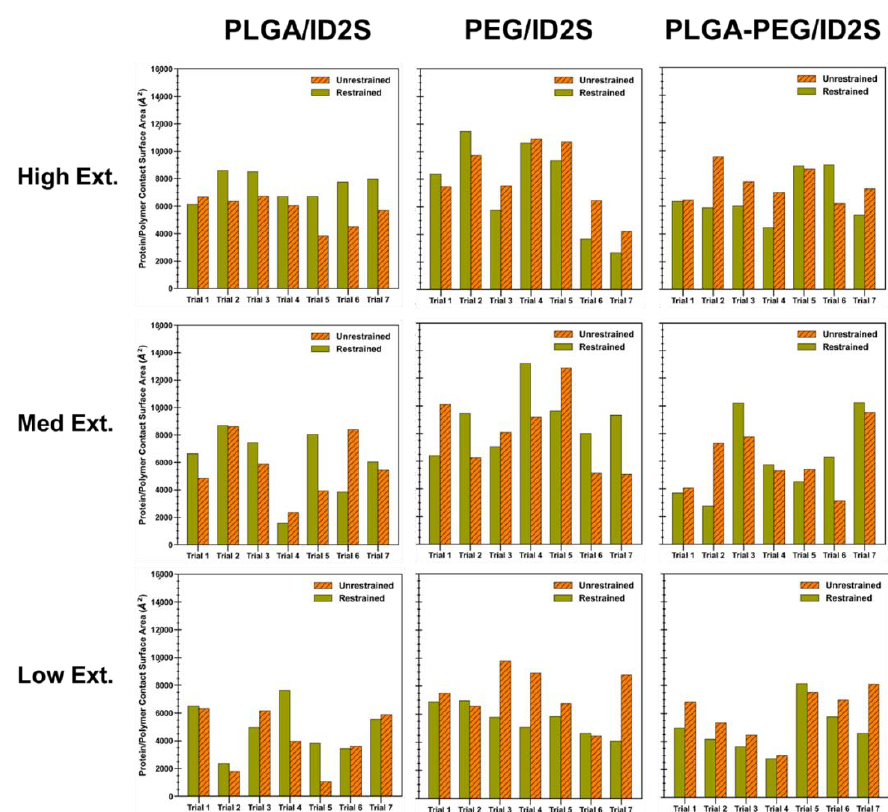
Figure A9. Protein–polymer contact surface area from each simulation trial across the different levels of extension and restraint phases for PLGA/ID2S ( left column), PEG/ID2S ( middle column), and PLGA-PEG/ID2S ( right column). For reference, the ID2S total surface area was 20,438 Å 2 .